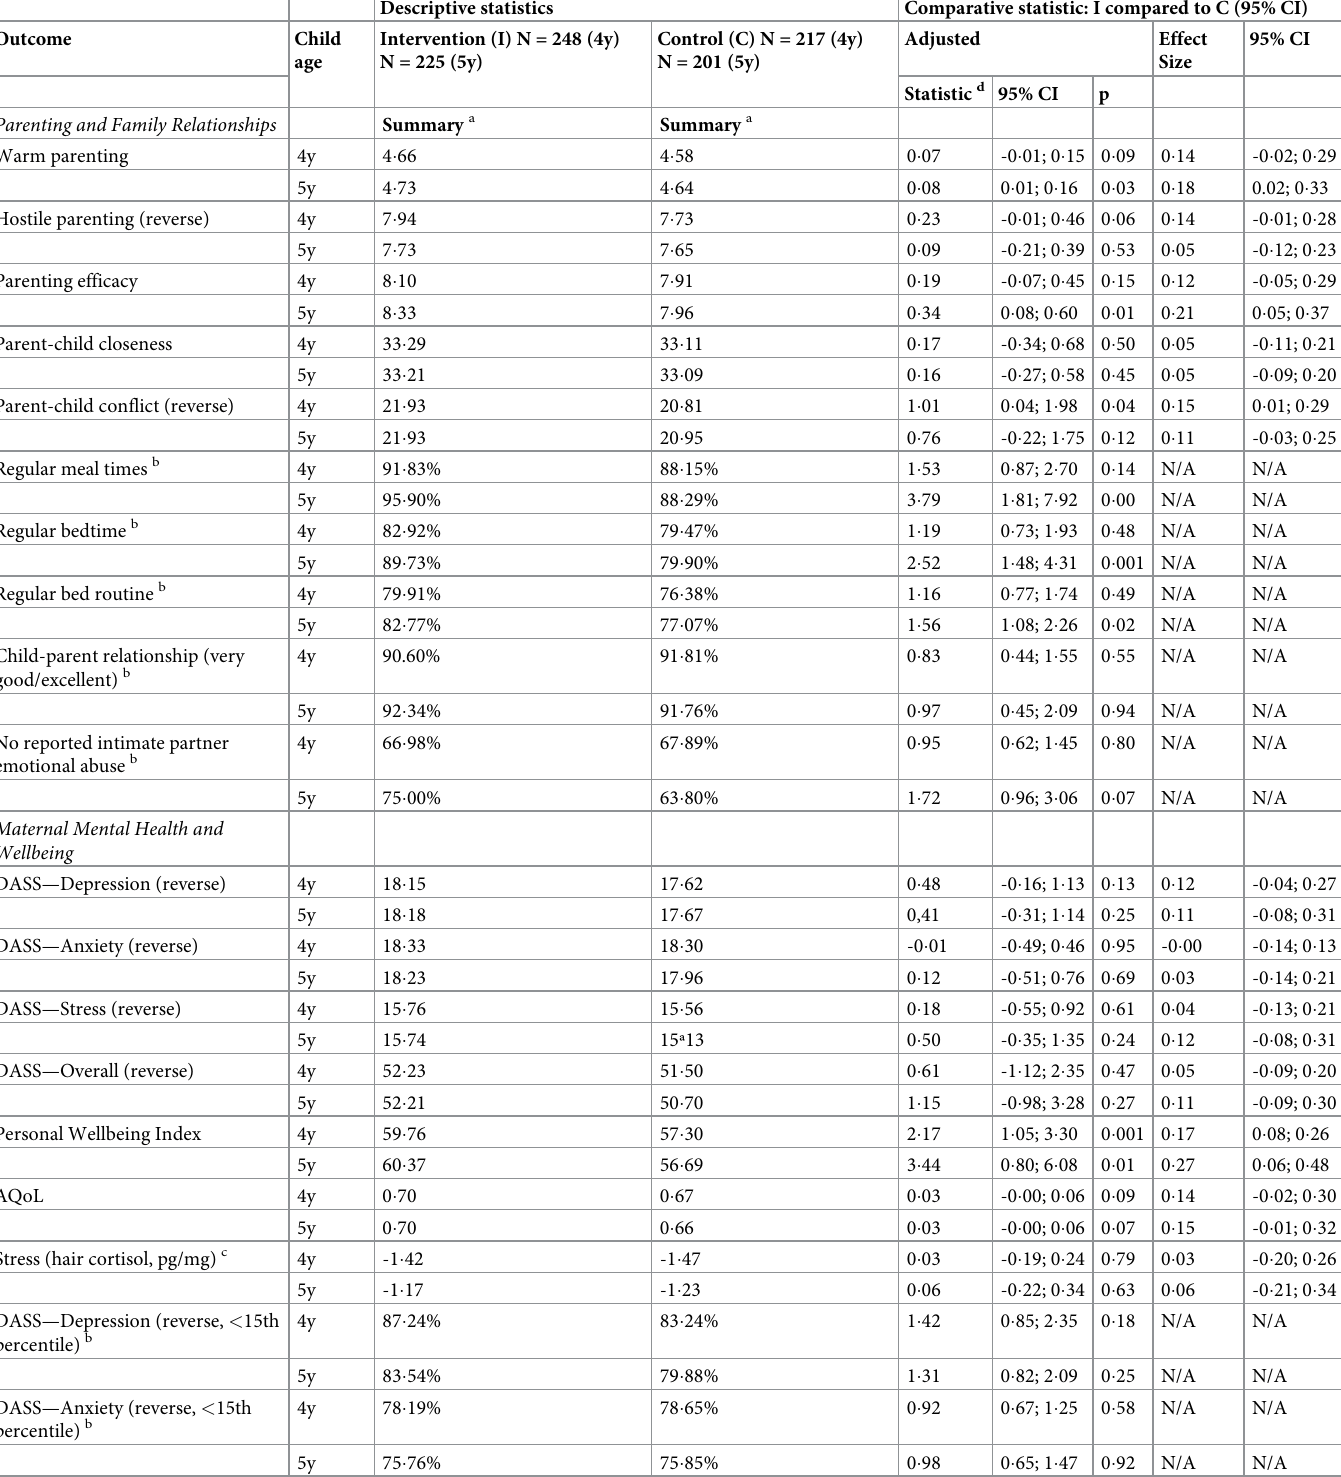
Table 4. Results of adjusted regression analyses comparing the two trial arms on maternal outcomes at child ages 4 and 5 years, using multiply imputed and inverse probability weighted